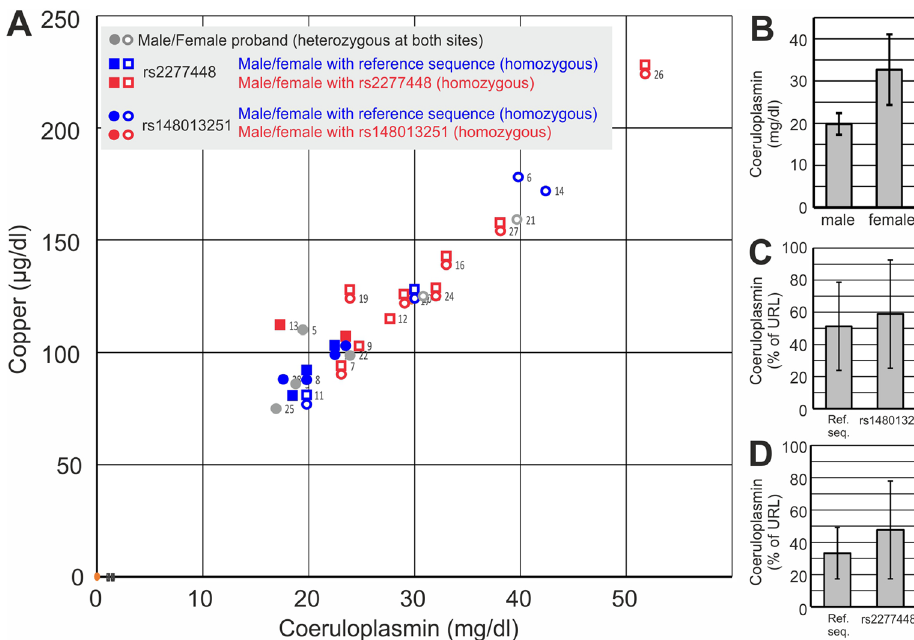
Figure 4. Promoter polymorphisms in relation to coeruloplasmin and copper blood levels. Rs2277448 and rs148013251 genotype, copper and coeruloplasmin serum levels were determined in 24 healthy probands. ( A ) Correlation of genotypes, sex, coeruloplasmin and copper serum levels in all individual probands. ( B ) Sex and coeruloplasmin levels. ( C ) and ( D ) Coeruloplasmin levels as percent value of individual (male and female) upper reference limits in individuals either having homozygous rs148013251 ( C ) or homozygous rs2277448 ( D ) in comparison to respective individuals with homozygous reference sequence (Ref. seq.).